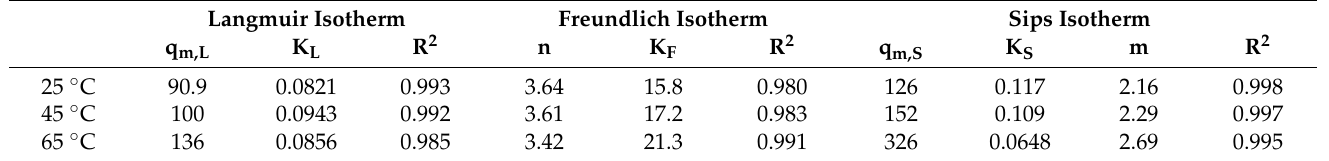
Figure 7. Isotherms of tungstate sorbed onto delaminated iron-based LDH and their fits to Sips model. Table 2. Isotherm parameters for tungstate sorption on delaminated iron-based LDH.